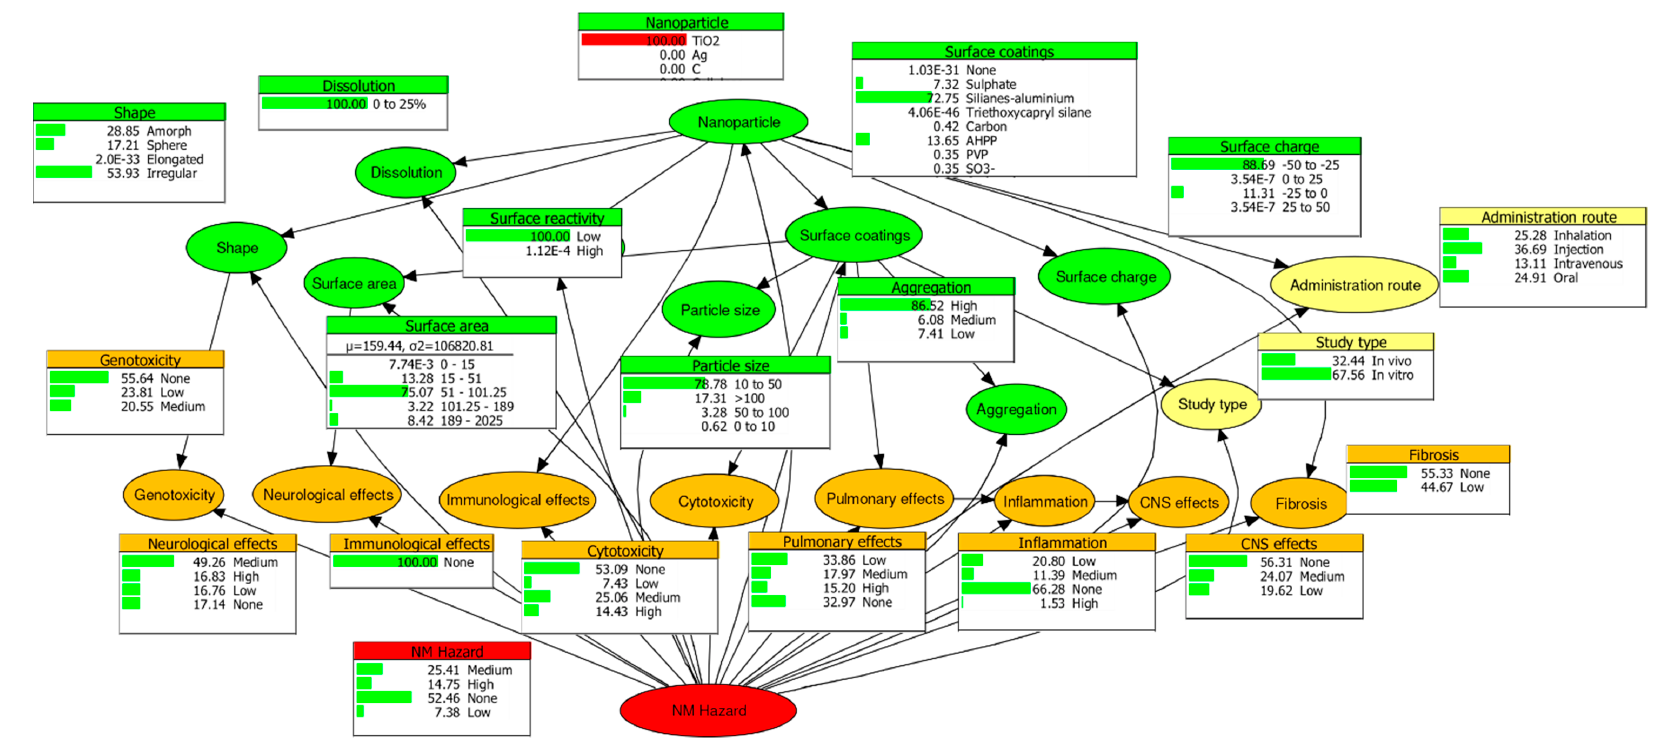
Figure 1. Graphical structure and parameterization of the Bayesian networks (BN) with TiO 2 as the sample nanomaterial (NM). Ellipses represent nodes and directed links signify the conditional relationship between parent and child nodes. The accompanying bar charts denote the % state probabilities. The nodes are colour categorised into green for physicochemical properties, yellow for experimental methodology, orange for biological effects, and red for NM hazard potential. Adapted from Marvin et al. [9].